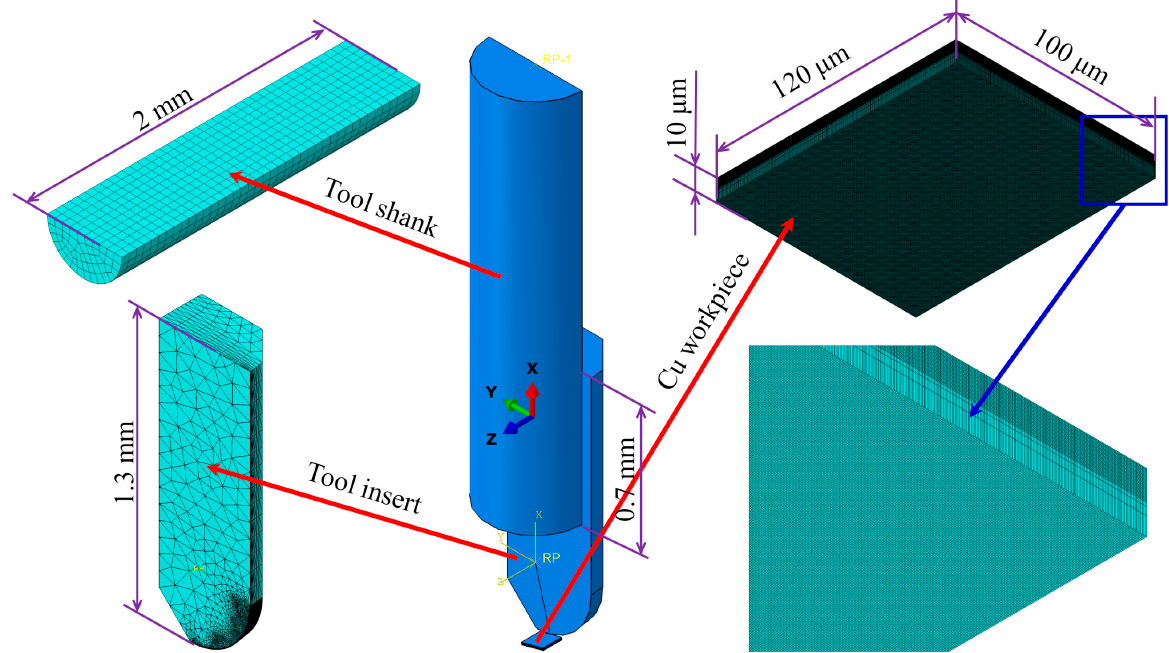
Figure 2. FE model of the micro-milling of Cu considering milling tool deformation.